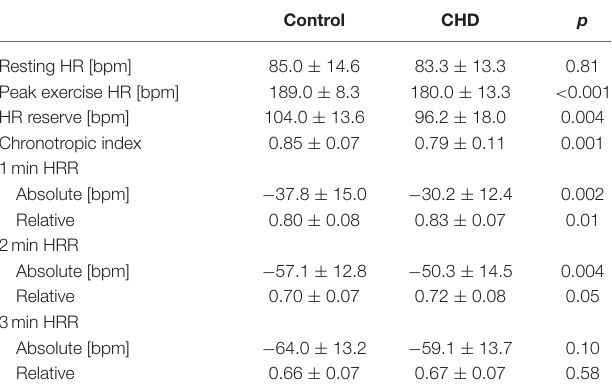
TABLE 3 | Heart rate characteristics during